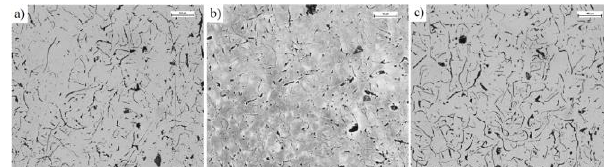
Fig. 11. Microscopic images of the analyzed brake discs shown in Fig. 10; in all cases flake precipitations of unmodified graphite are visible; they are characterized only by the variation of the size of the precipitates, and their shape and way of distribution are similar to each other; unetched state, light